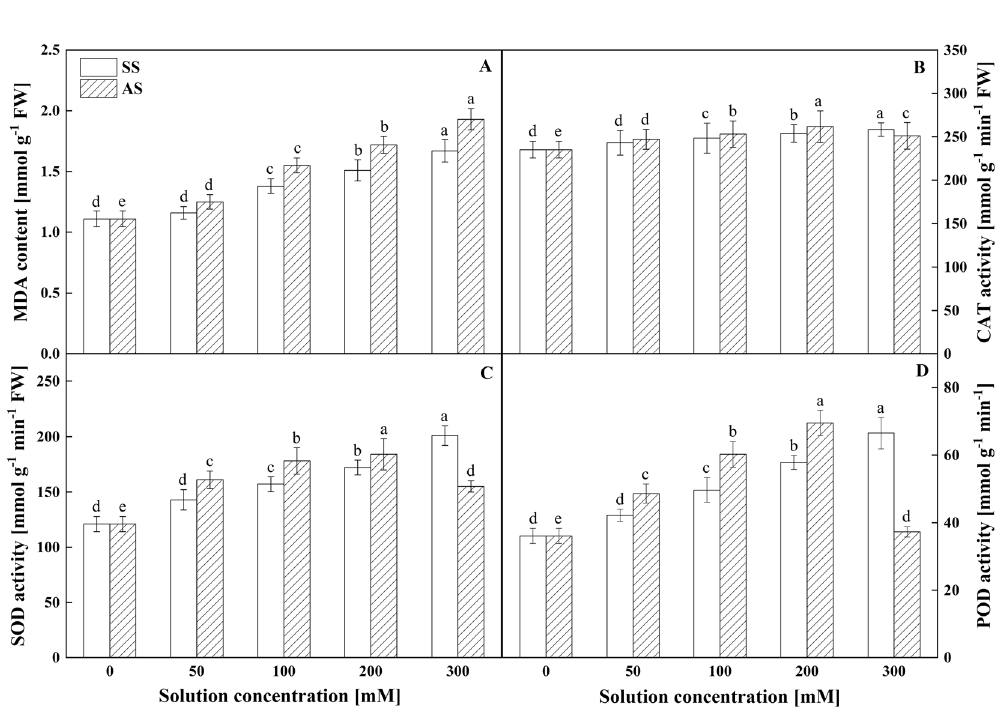
Figure 5. Effects of NaCl and NaHCO 3 concentrations on ( A ) malondialdehyde (MDA) levels, ( B ) catalase (CAT) activity, ( C ) superoxide dismutase (SOD) activity, and ( D ) peroxidase (POD) activity in the leaves of Goji berry. Values are represented as the mean ± SE (n = 5). Different letters indicate a significant difference at P < 0.05 by the least significant difference (LSD)